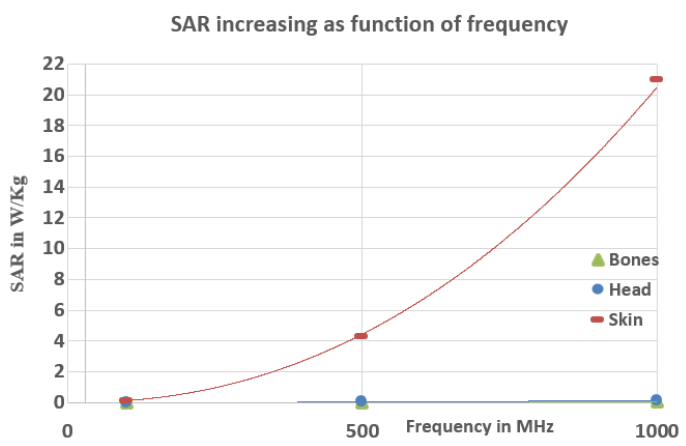
Figure 8. SAR increasing as function of frequency. Figure 8. 𝑆𝐴𝑅 increasing as function of frequency. Figure 8. 𝑆𝐴𝑅 increasing as function of frequency.